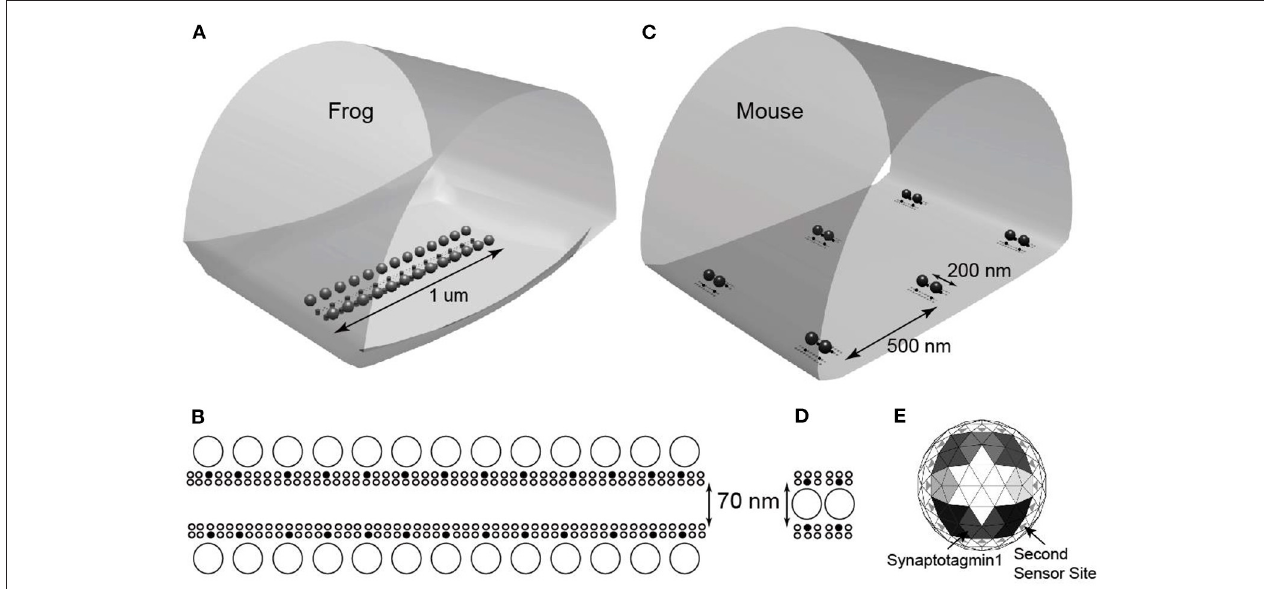
FIGURE 5 | Representations of MCell models used for frog and mouse active zones. (A) The MCell geometry used to model the frog AZ. (B) Detail of AZ organization of docked synaptic vesicles (large open circles), VGCCs (small filled circles), and other AZ proteins (small open circles). (C) The MCell geometry used to model six mouse AZs. (D) Detail of AZ organization of docked synaptic vesicles (large open circles), VGCCs (small filled circles), and other AZ proteins (small open circles). (E) Diagram of the undersurface of docked synaptic vesicles. The model represents eight synaptotagmin-1 molecules (shaded large triangles; differences in shading depict the 5 binding sites for each of the 8 synaptotagmin-1 proteins), and 16 synaptotagmin-7 proteins (small gray triangles). Adapted from Laghaei et al. (2018).